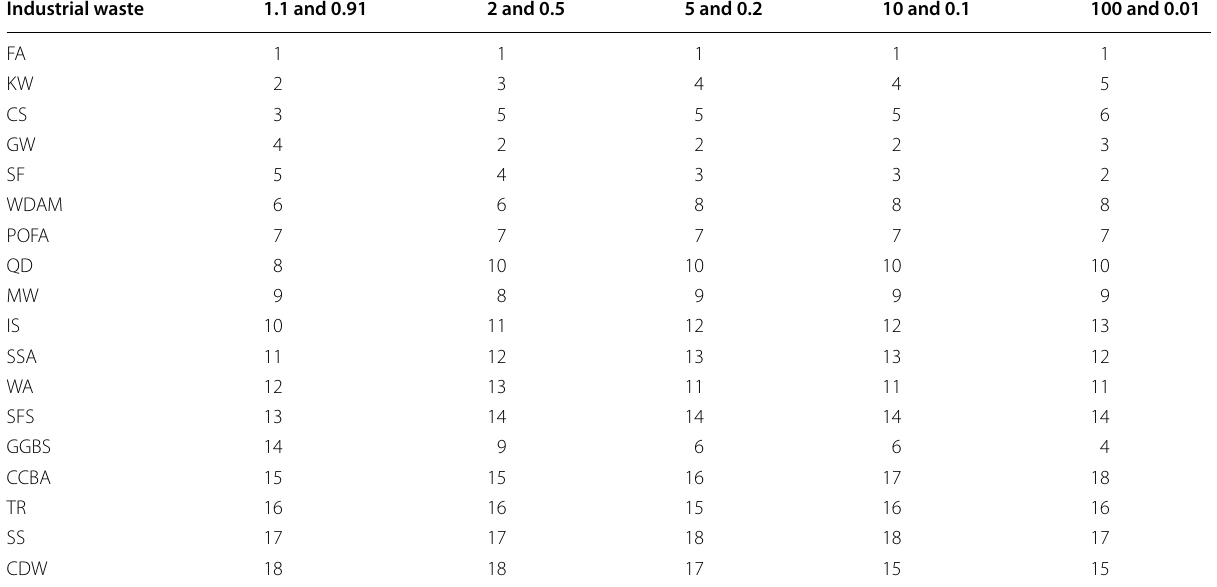
Table 5 Order of alternatives using different reciprocal values. Industrial